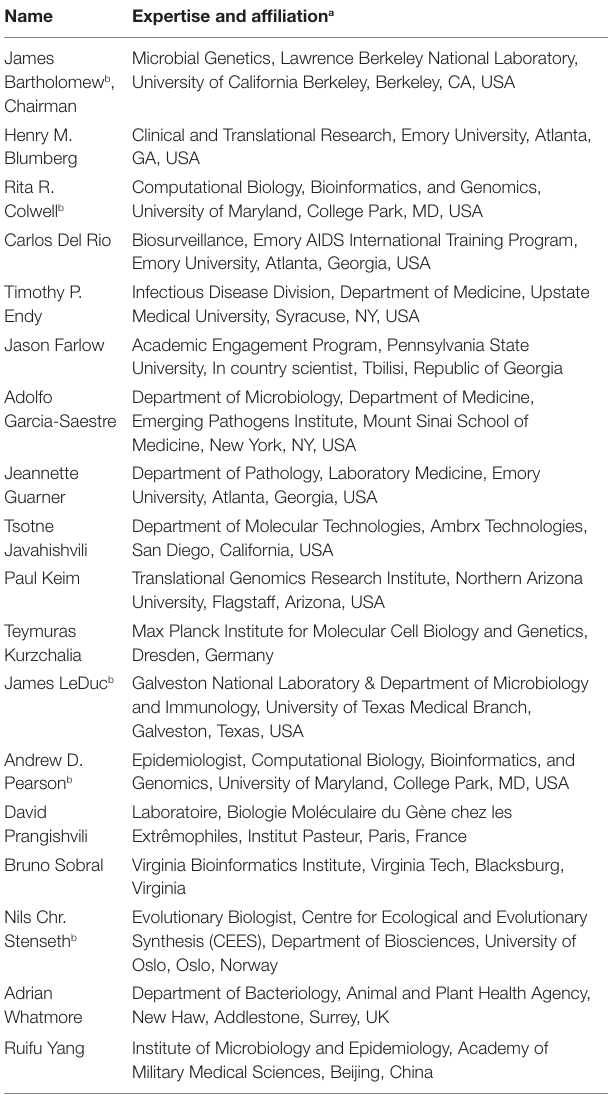
TABLe 1 | international Science Advisory Committee